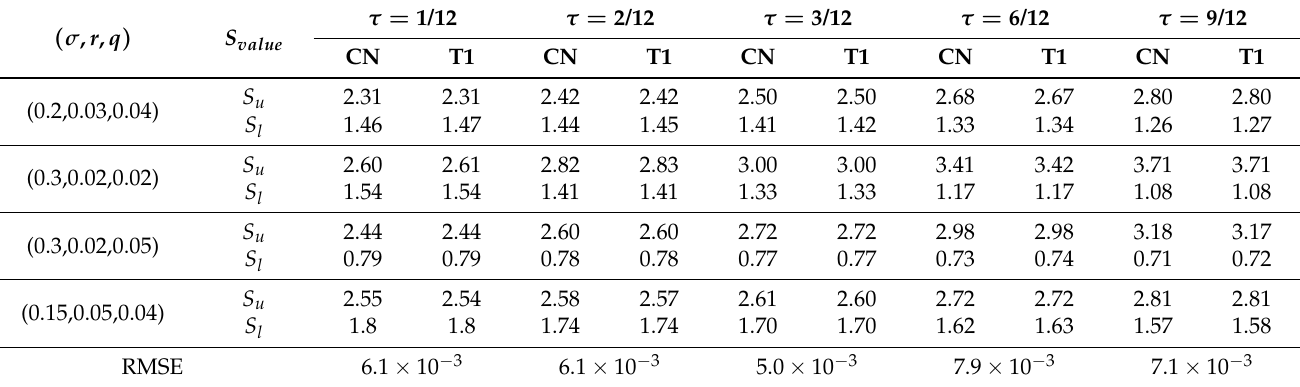
Table 2. Comparison of optimal exercise stock prices ( S u , the upper price and S l , the lower price) with X = 2 using Theorem 1 (1) and the Crank–Nicolson scheme